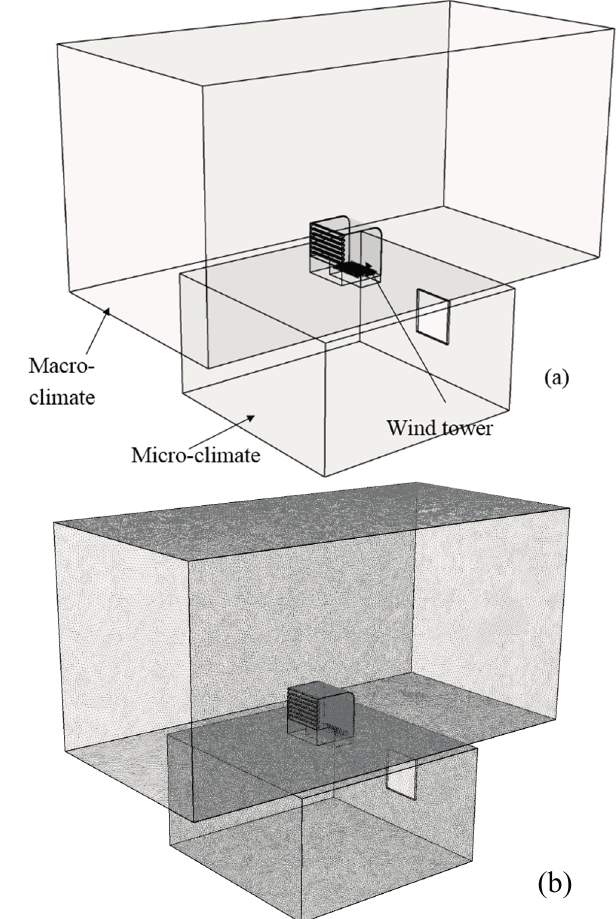
Figure 5. ( a ) Illustration of the geometry; ( b ) Meshing of the macro-climate, wind tower and test